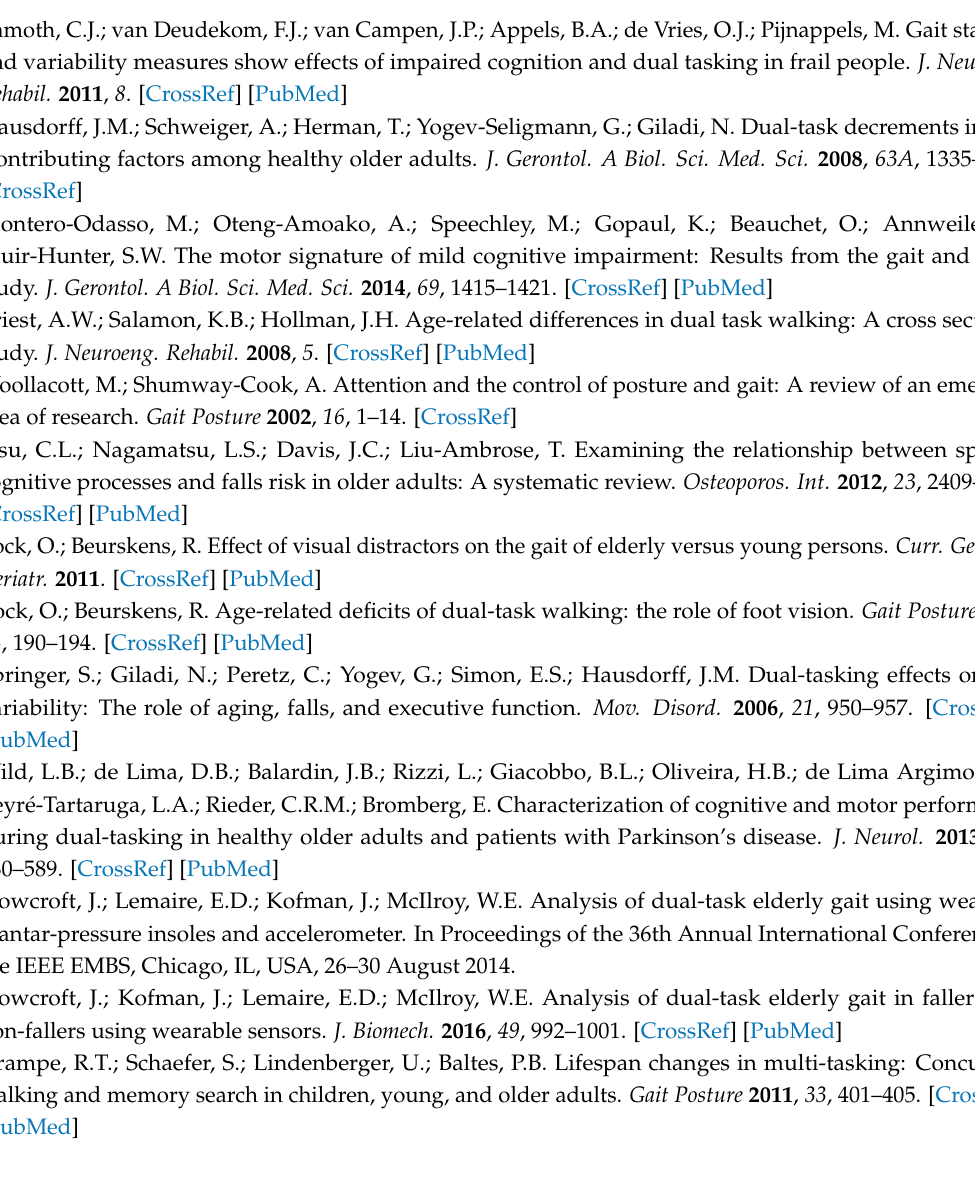
s1, Supplementary Tables S1: Mixed-design ANOVA tests results for pressure-sensing insole variables, Table S2: Mixed-design ANOVA tests results for head accelerometer variables, Table S3: Mixed-design ANOVA tests results for posterior pelvis accelerometer variables, Table S4: Mixed-design ANOVA tests results for right shank accelerometer variables, Table S5: Mixed-design ANOVA tests results for left shank accelerometer